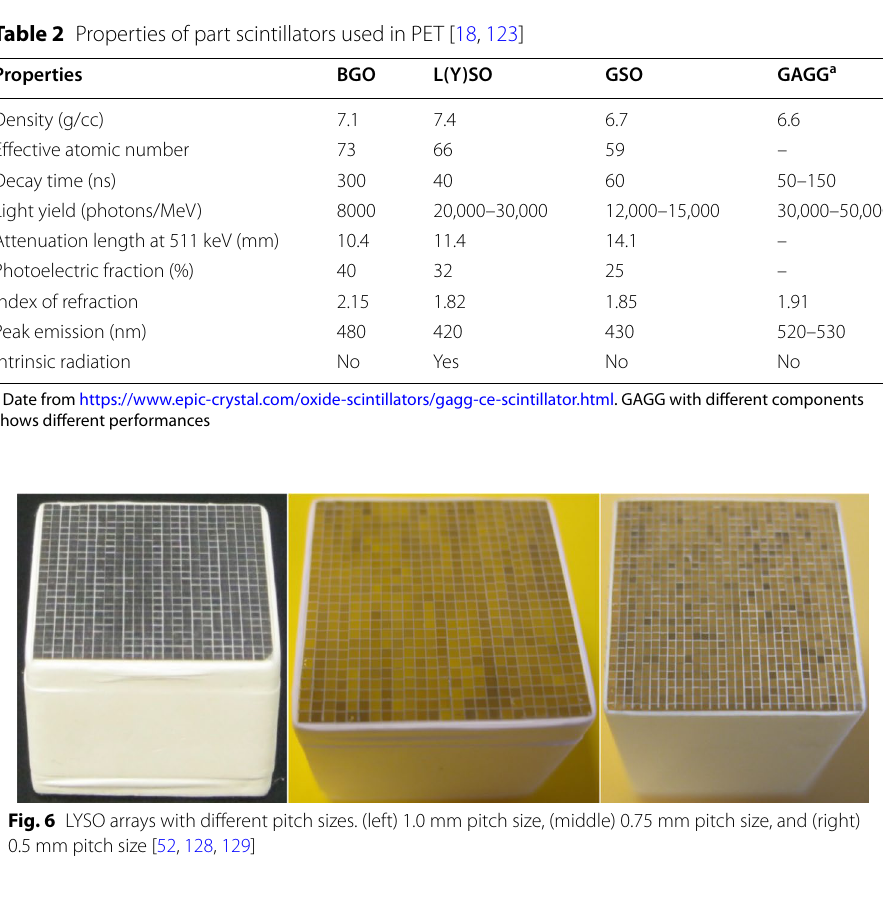
Table 2 Properties of part scintillators used in PET [18, 123]